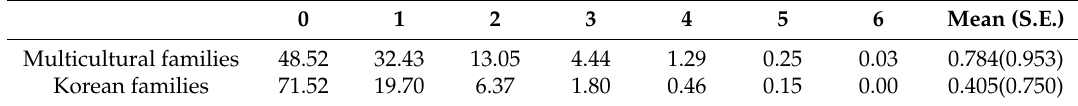
Table 2. Comparisons of the multiplexity of social